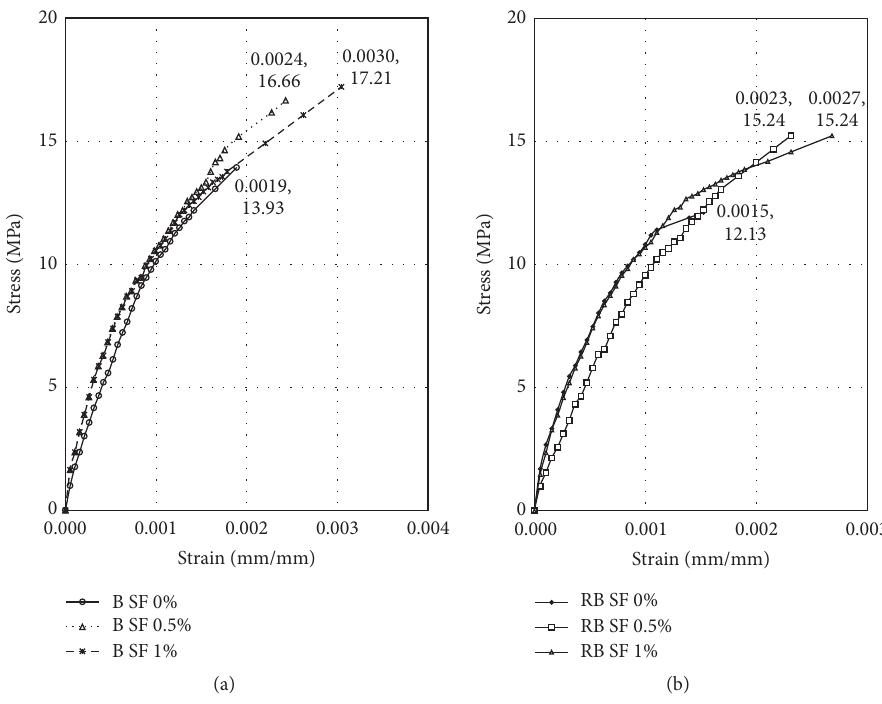
Figure 11: Stress-strain diagram at 7 day; (a) B aggregate and (b) RB